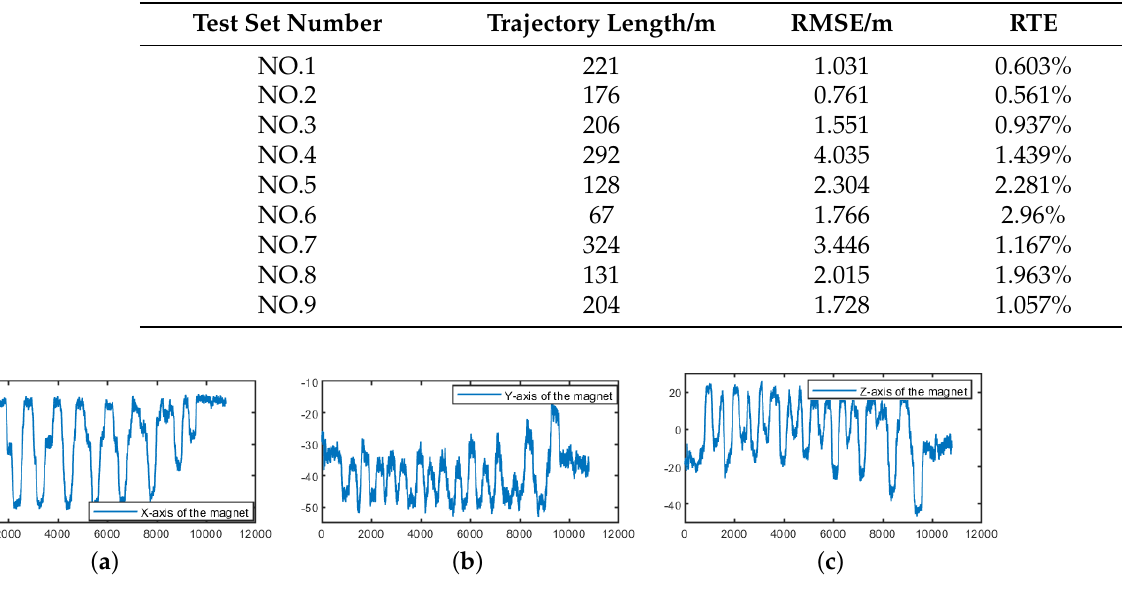
Figure 5. The raw magnet data of this experiment. ( a ) X-axis magnetometer data, ( b ) Y-axis magne- tometer data, ( c ) Z-axis magnetometer data.